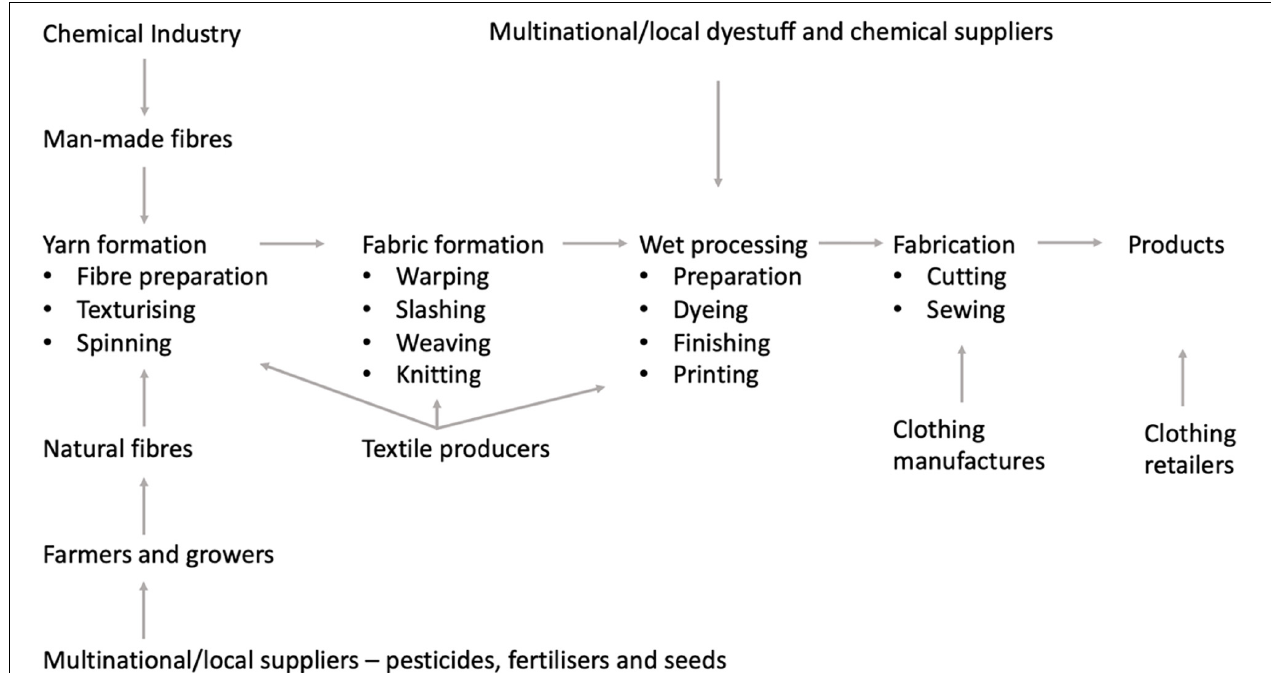
FIGURE 12 | The business involved in the textile and clothing supply chain [adapted from Choudhury (2014)]. TABLE 3 | LCA cradle-to-gate of different impact categories per 1000 kg of fiber (functional unit) produced under different methods. Impact Category Cotton Fiber Tencel (lyocell) Viscose Austria Viscose Asia Polyester Water Use (m 3 ) 5730 1 263 2 445 2 319 3 125 3 Energy Demand (GJ) 55 1 65 3 70 3 106 3 96 3 Global Warming (kg CO 2 -Equiv.) 2000 1 50 3 − 250 3 3800 3 4100 3 Acidification (kg SO 2 -Equiv.) 41 1 Eutrophication (kg phosphate-Equiv.) 22 1 Ozone Depletion ( × 10 − 3 kg CFC11 Equiv.) Land Use (ha/year) 1.07